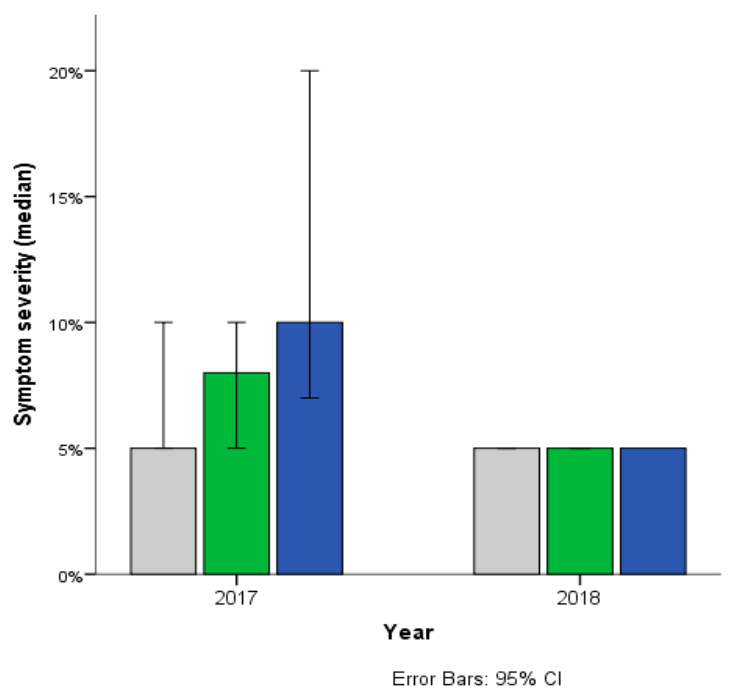
Figure 6. Symptom severity of Rhizoctonia sp. infection with three treatments, assessed in 2017 and